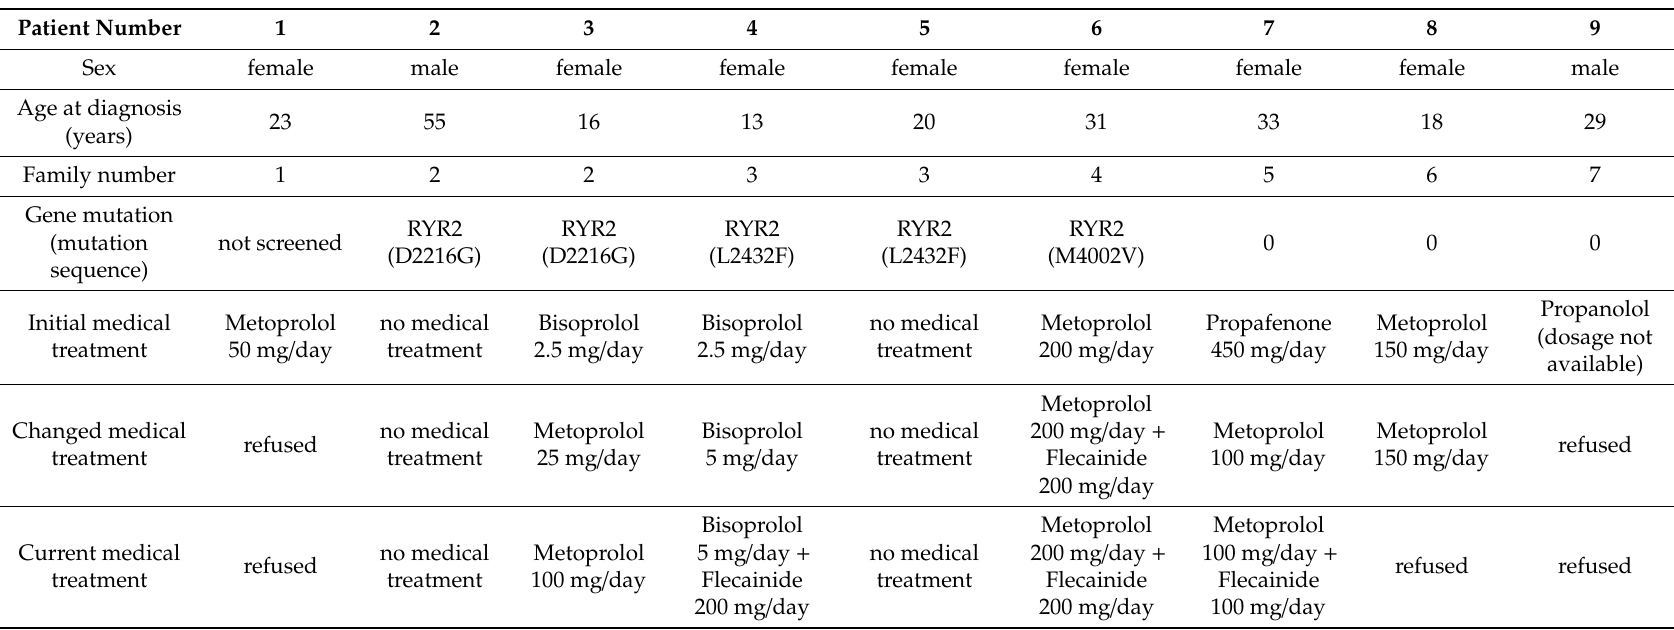
Table 2. Details of the